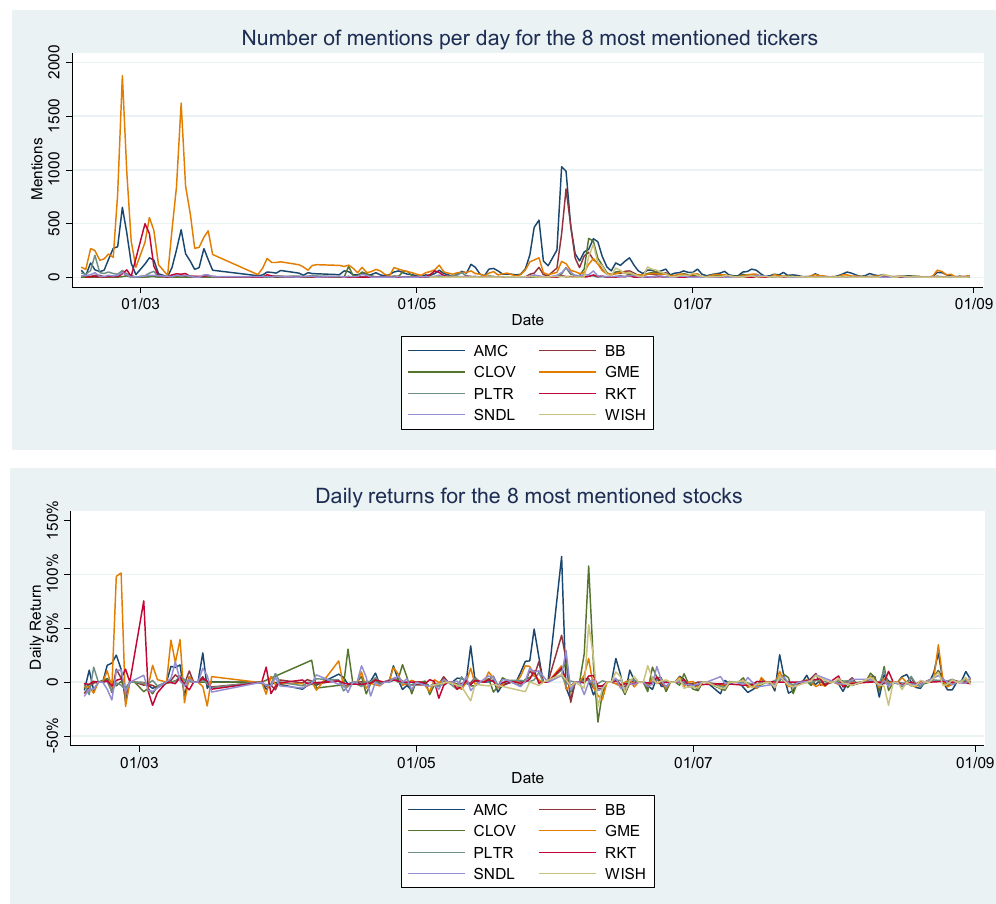
Figure 5. Line charts for the daily number of mentions ( above ) and return ( below ) of the eight most mentioned